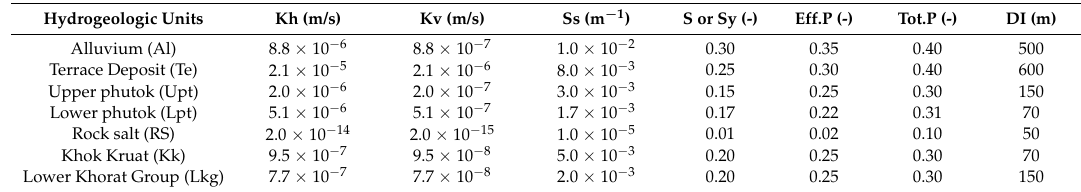
Table 3. Hydraulic parameters used in simulations of groundwater flow and solute transport in the SEAWAT model.